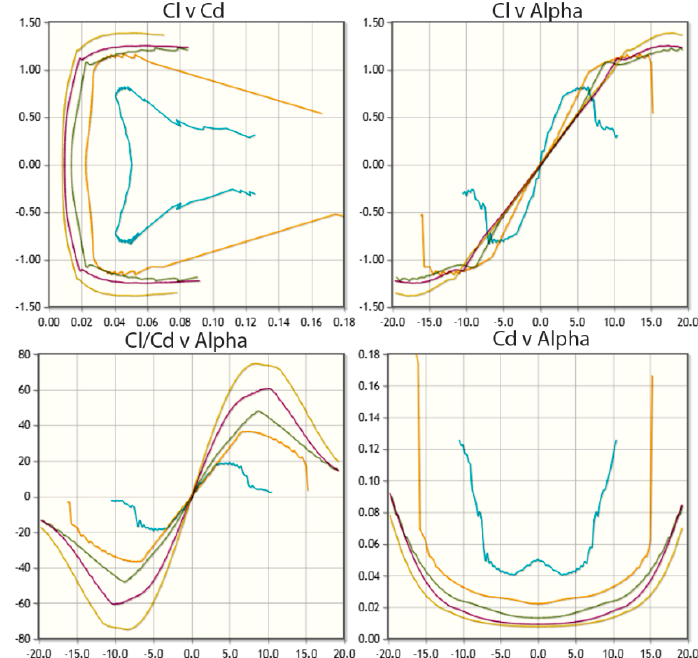
Figure 3. Profile characteristics of the naca0021-il.